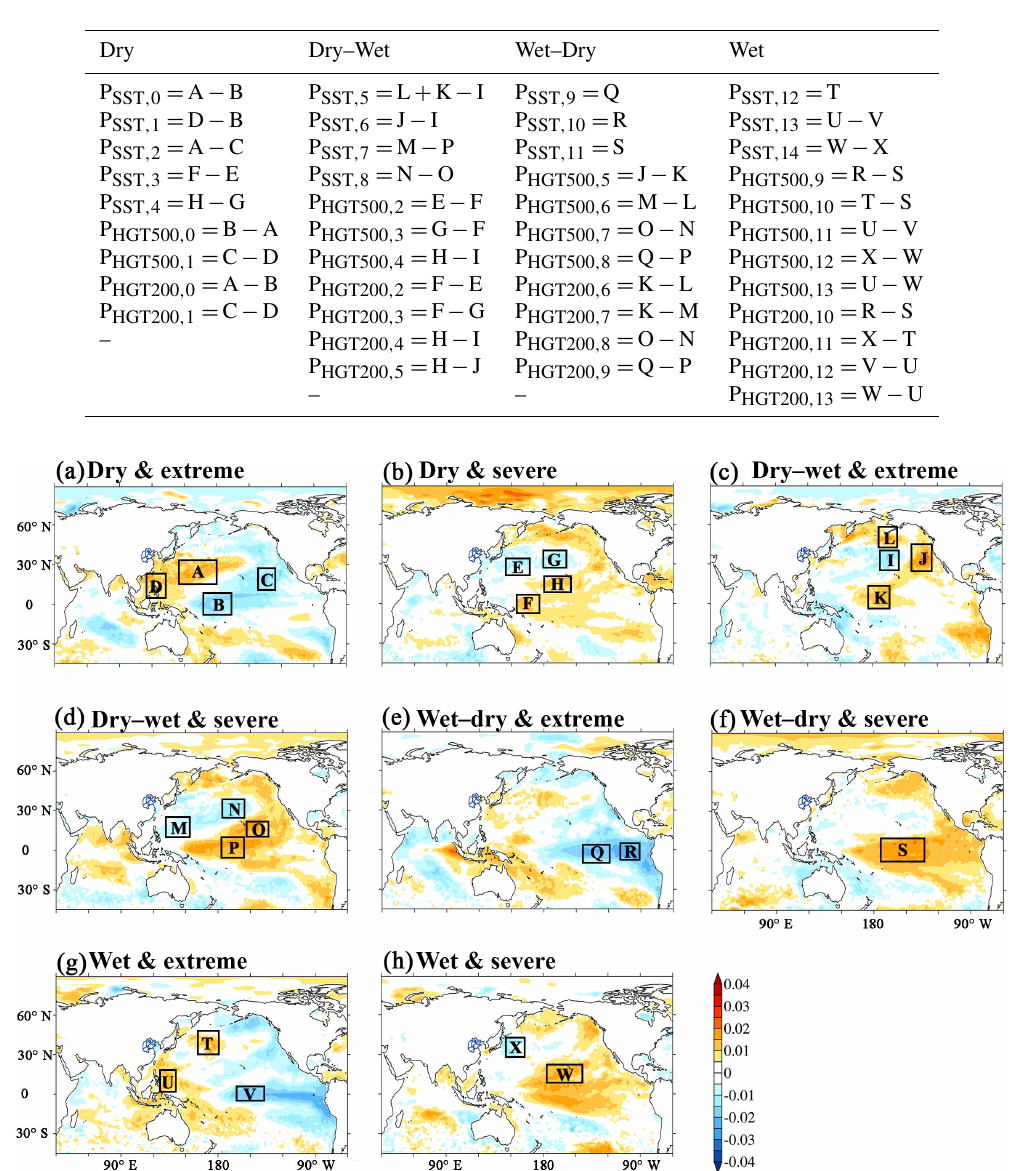
Table 5. Predictor-structured results based on the first leading empirical orthogonal function (EOF) modes for SAs of 200hPa HGT, 500hPa HGT, and SST fields during different dry and wet spells in northern China. Capital letters refer to the code for selected areas in Figs. 7, 8, and S2. In the term “P XXX , Y ”, P, XXX, and Y refer to predictors, atmospheric or oceanic elements, and the code of new predictors, respectively.